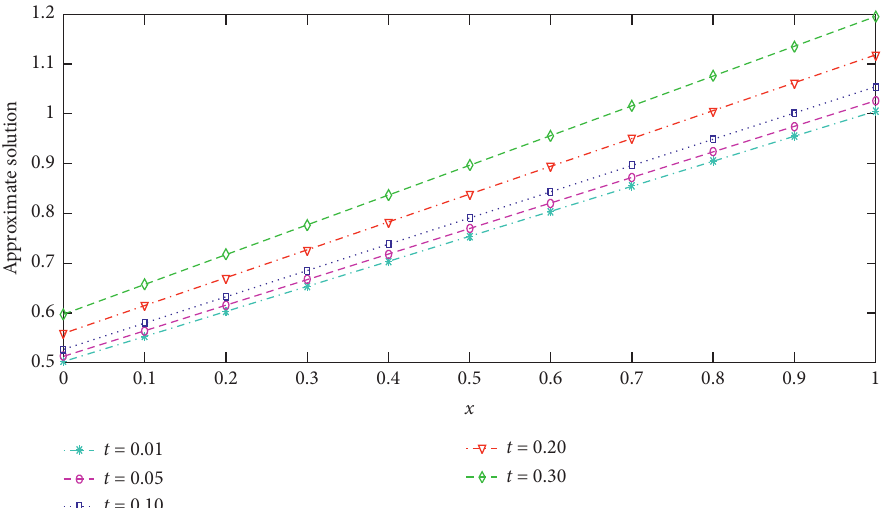
Figure 1: The results of MVIA-II for Test Problem 4.1 for different values of time.